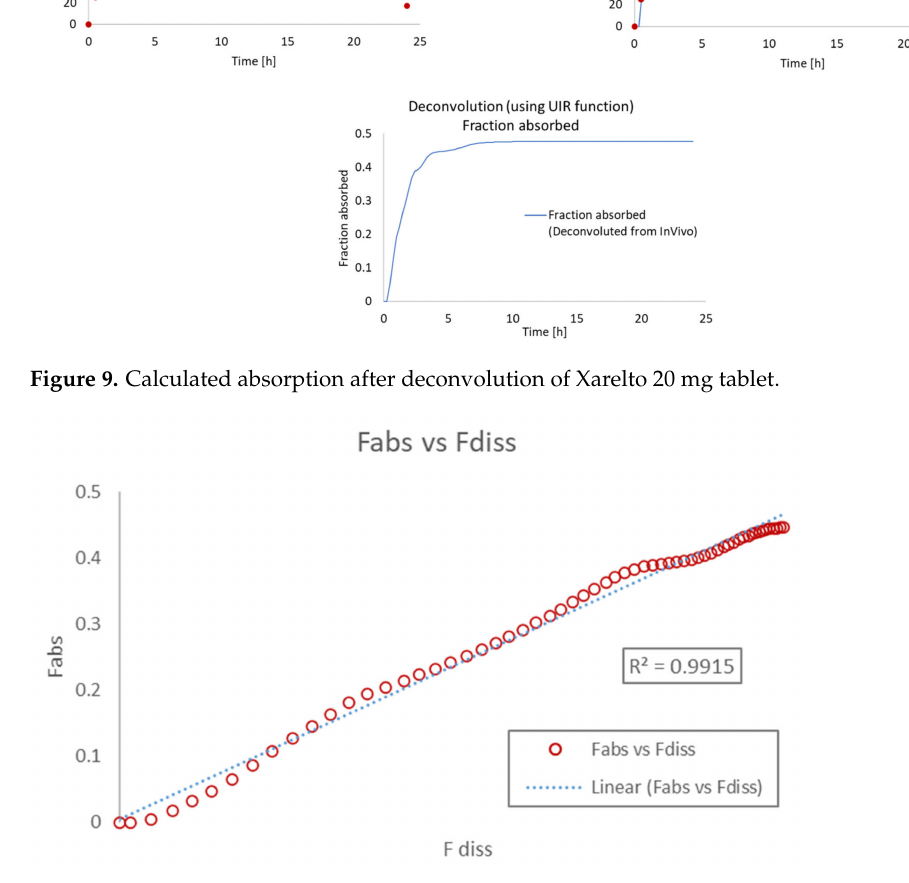
Figure 10. Fraction absorbed in vivo vs. fraction dissolved in vitro for the Xarelto 20 mg tablet in the fasted